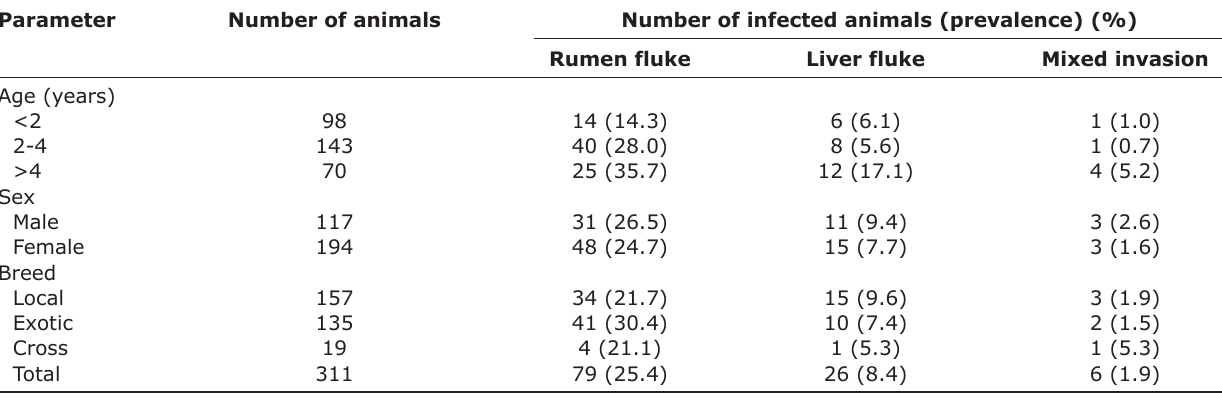
Table-2: Prevalence of fluke infection in beef cattle reared around Phayao Lake according to the age, sex, and breed of cattle. Parameter Number of